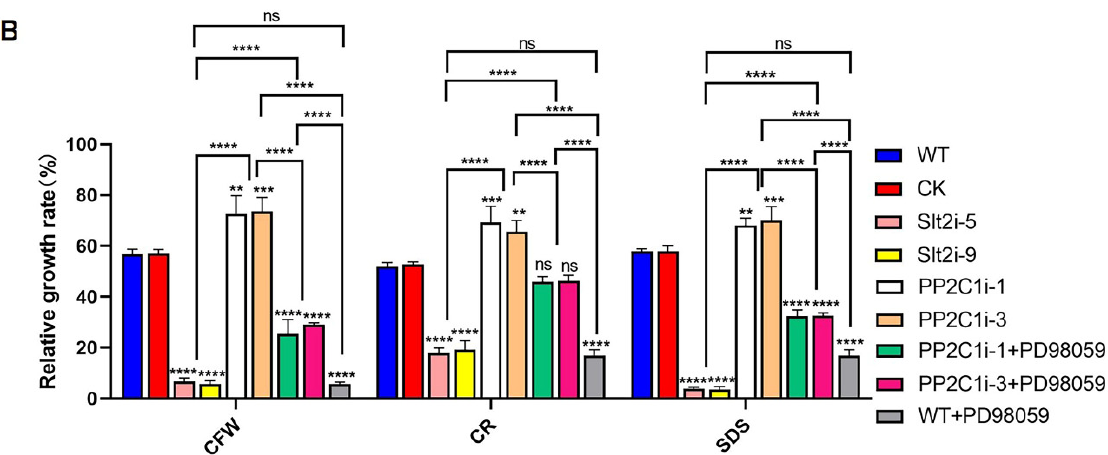
Figure 6. Sensitivity of different strains to cell wall-disrupting compounds. ( A ) The PP2C-silenced, WT, CK, Slt2-silenced and PP2C-silenced strains treated with 20 µ M PD98059 were cultured on CYM plates under different cell wall stresses. ( B ) Relative growth rates of the PP2C-silenced, WT, CK, Slt2-silenced and PP2C-silenced strains under cell wall stress in the treated with 20 µ M PD98059. The relative growth rates (%) of the different strains in the presence of the indicated stressors were calculated as the colony area on stressor-containing medium versus the colony areas on CYM. The data are presented as the mean ± SDs from three independent experiments (* p < 0.05, ** p < 0.01, *** p < 0.001 and **** p < 0.0001 by one-way ANOVA).